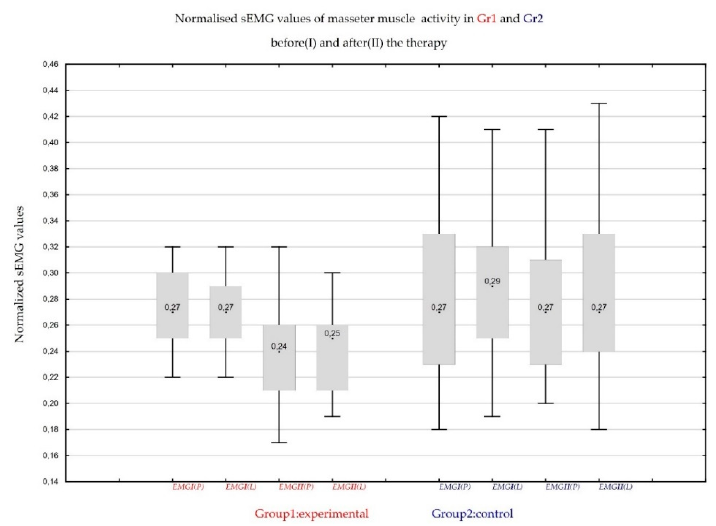
Figure 4. Normalized surface electromyographic (sEMG) mean values of masseter muscle activity at rest position in Group1 and Group2; on Day 0 (I) and on follow-up visit on Day 14 (II) of the therapy; on left (L) and right (R) masseter muscle.